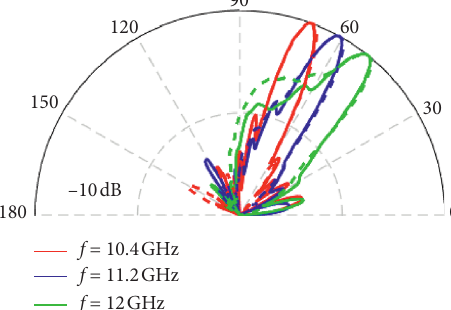
Figure 19: The measured radiation pattern of the proposed pe- riodic MLWA in the forward (—— measured ----